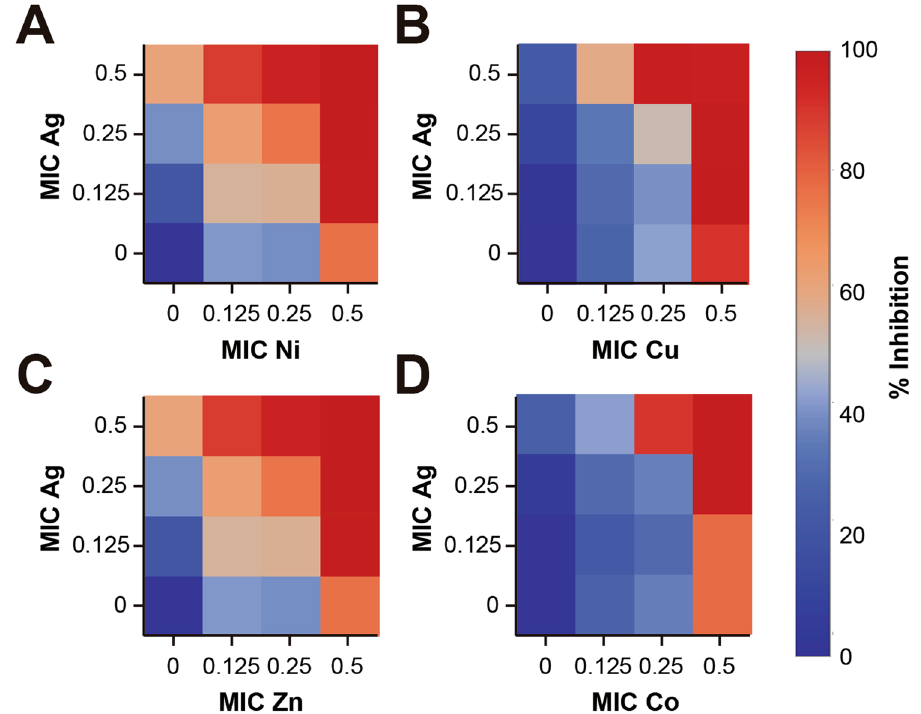
Figure 2. Inhibitory Effect of the MIC dilutions of Ag potentiated by transition metals against Bacillus subtilis . Inhibitory percentage by sub-inhibitory combinations of Ag-transition metals in Bacillus subtilis ATCC 23857. Experiments with combinatorial treatments of Ag with ( A ) Ni, ( B ) Cu, ( C ) Zn and ( D ) Co. Each combinatorial treatment with inhibition > 80% is significantly different to the effects of the individual treatments. Each checkerboard treatment was done in